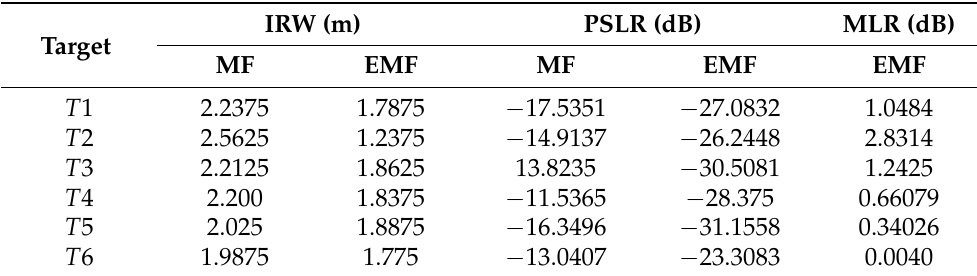
Table 6. Measurements of IRW, PSLR, and MLR for the targets of the outdoor experiment.